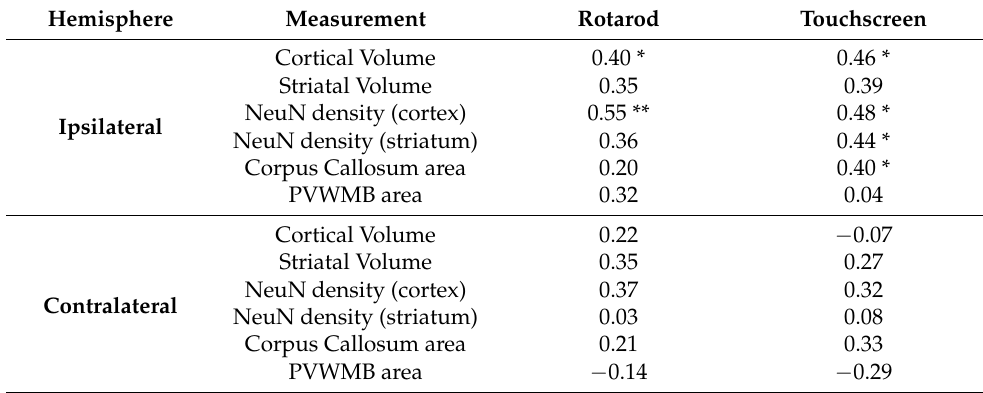
Table 1. Pearson’s r correlation coefficients between histological measurements and behavioural assessment scores show a number of significant associations between specific histopathological outcomes and functional deficits. It is interesting to note that these relationships all exist only for histological changes ipsilateral to the ischemic injury, suggesting a lateralisation of impairment that could manifest in measures of motor and cognitive behaviour. * p < 0.05, ** p < 0.01. Hemisphere